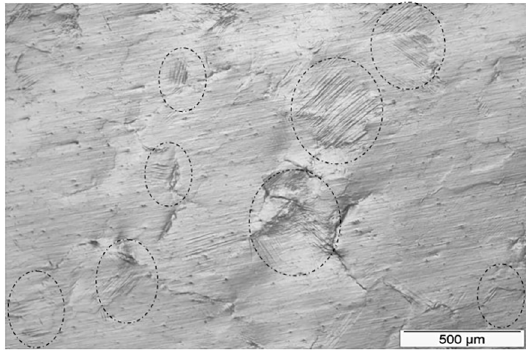
Figure 10. Areas of residual martensite after 5% deformation cycle for alloy Cu-11.8Al-0.6Be-0.5Nb (wt.%) at a temperature of 25 ºC.